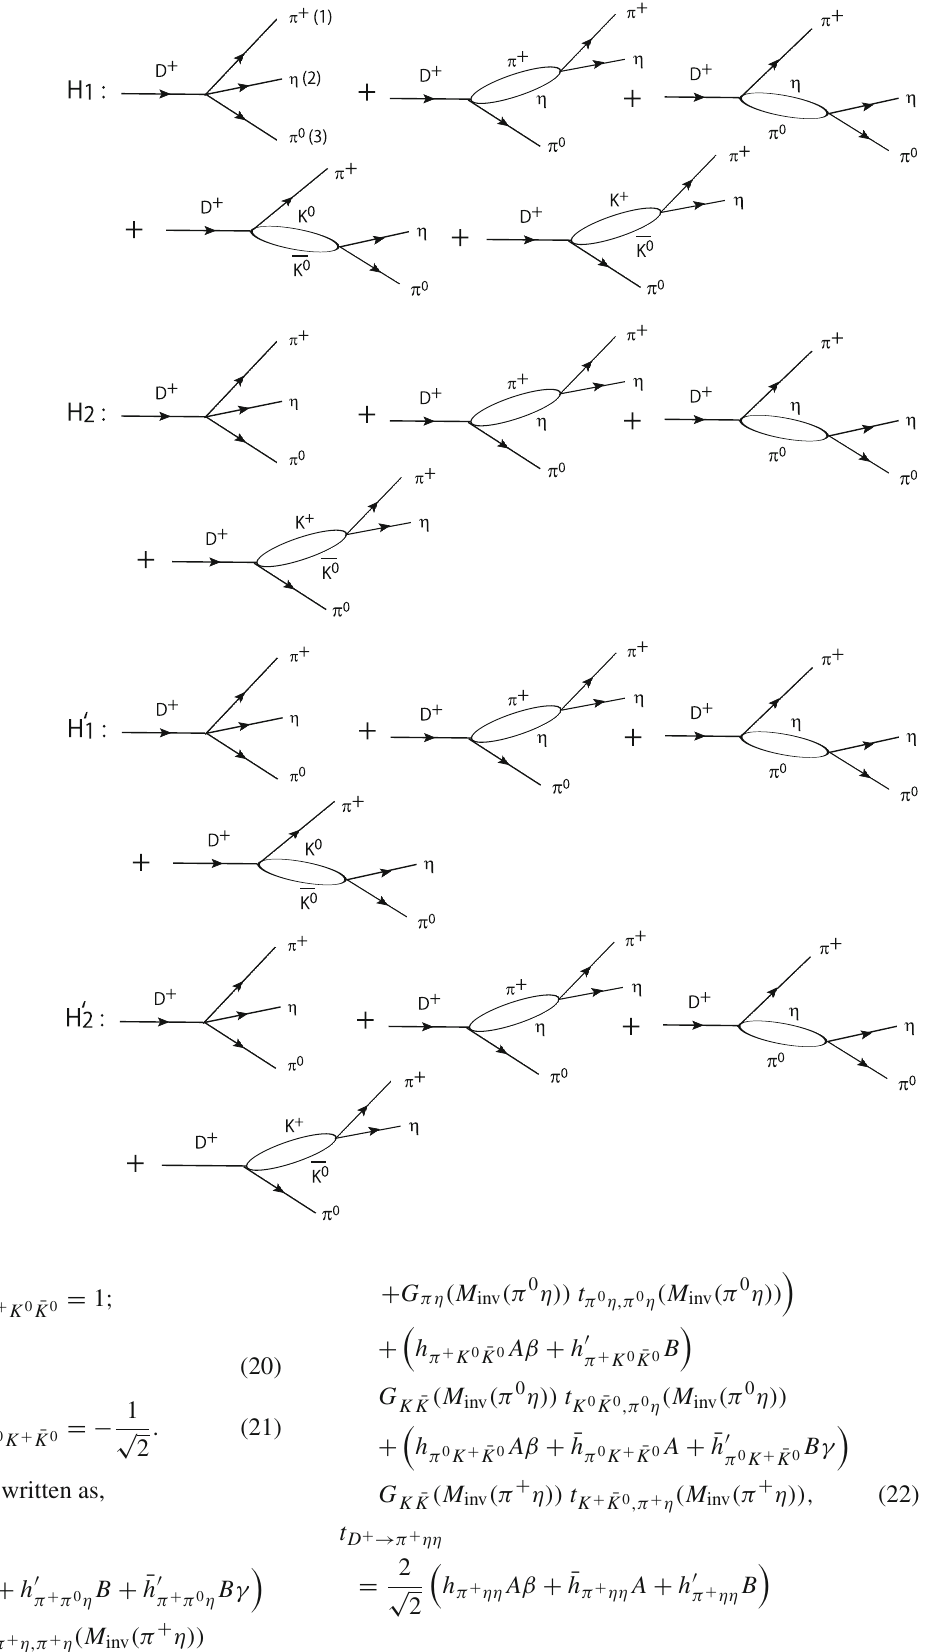
Fig. 5 Rescattering of terms to produce π + π 0